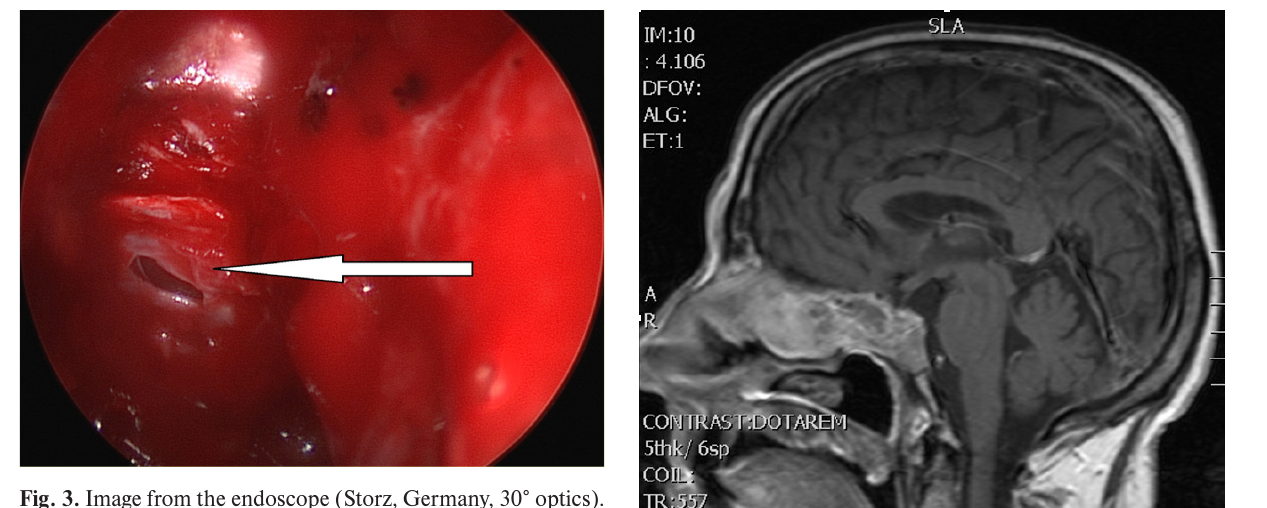
Fig. 3. Image from the endoscope (Storz, Germany, 30° optics). Visible meningocele defect after incision, indicated by an arrow.